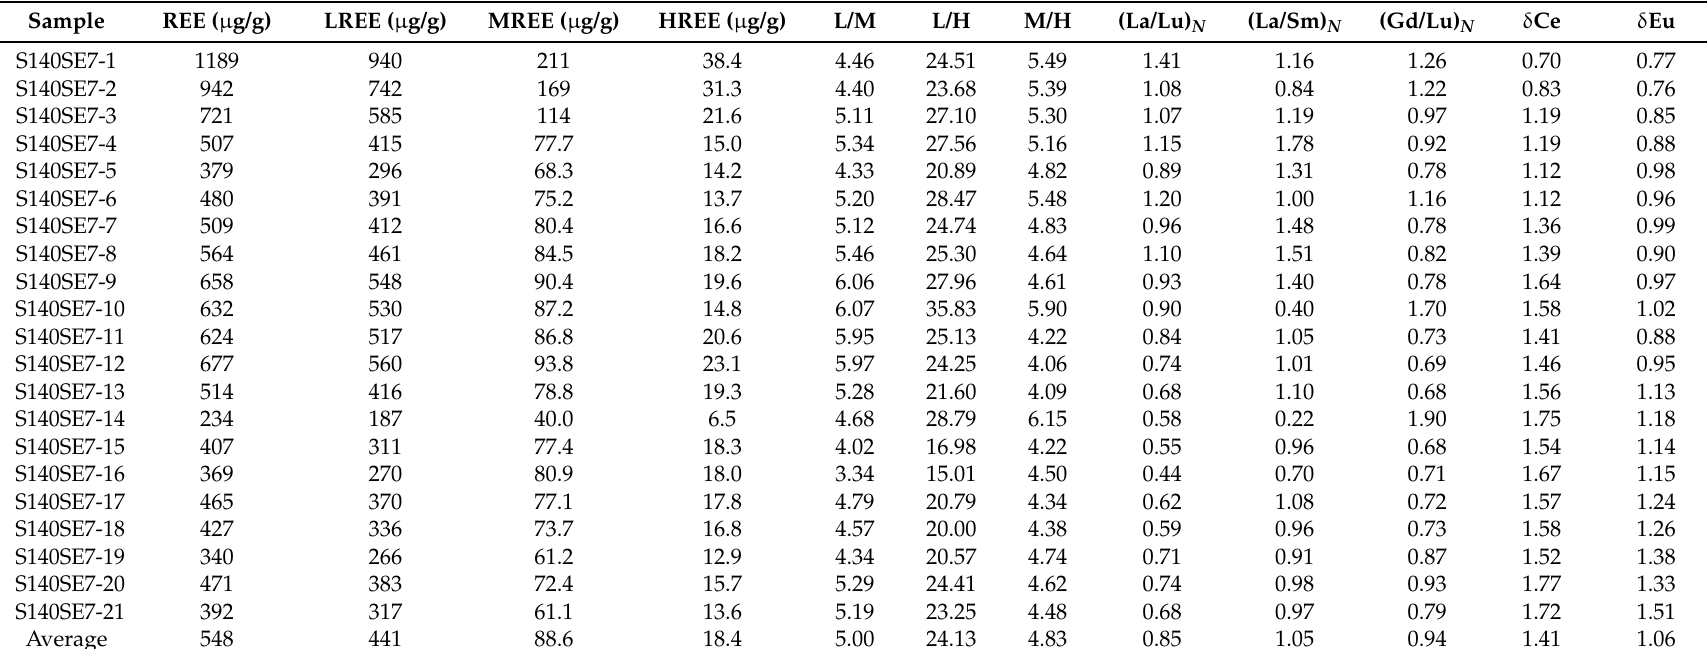
Table 4. Rare earth elements geochemical parameters of Zhongliangshan